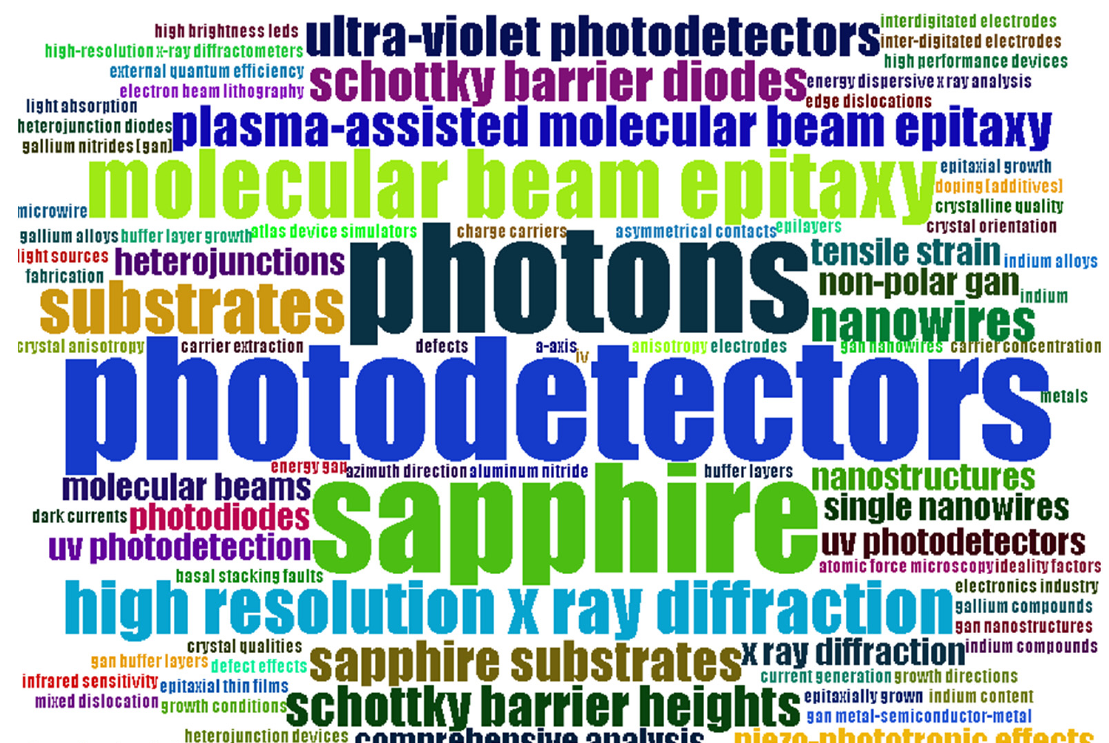
Figure 8. Keyword plus co-occurrence network of non-polar GaN-based photodetectors.